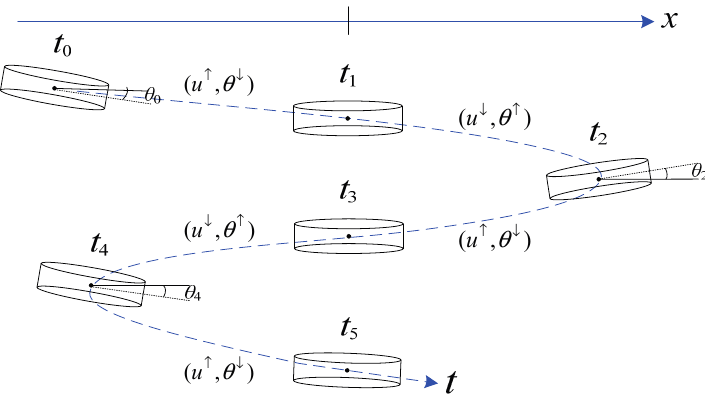
Figure 2. A schematic diagram illustrating the pitching and horizontal moving